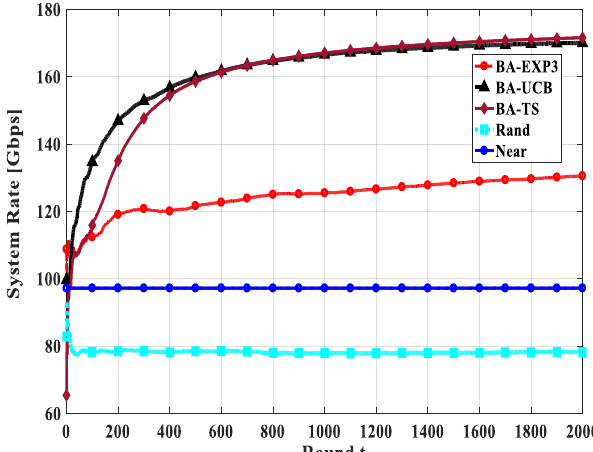
Figure 11. The convergence of system rate using access UAVs of 30, gateway UAVs of 20, and a beam-width of 60 ◦ .